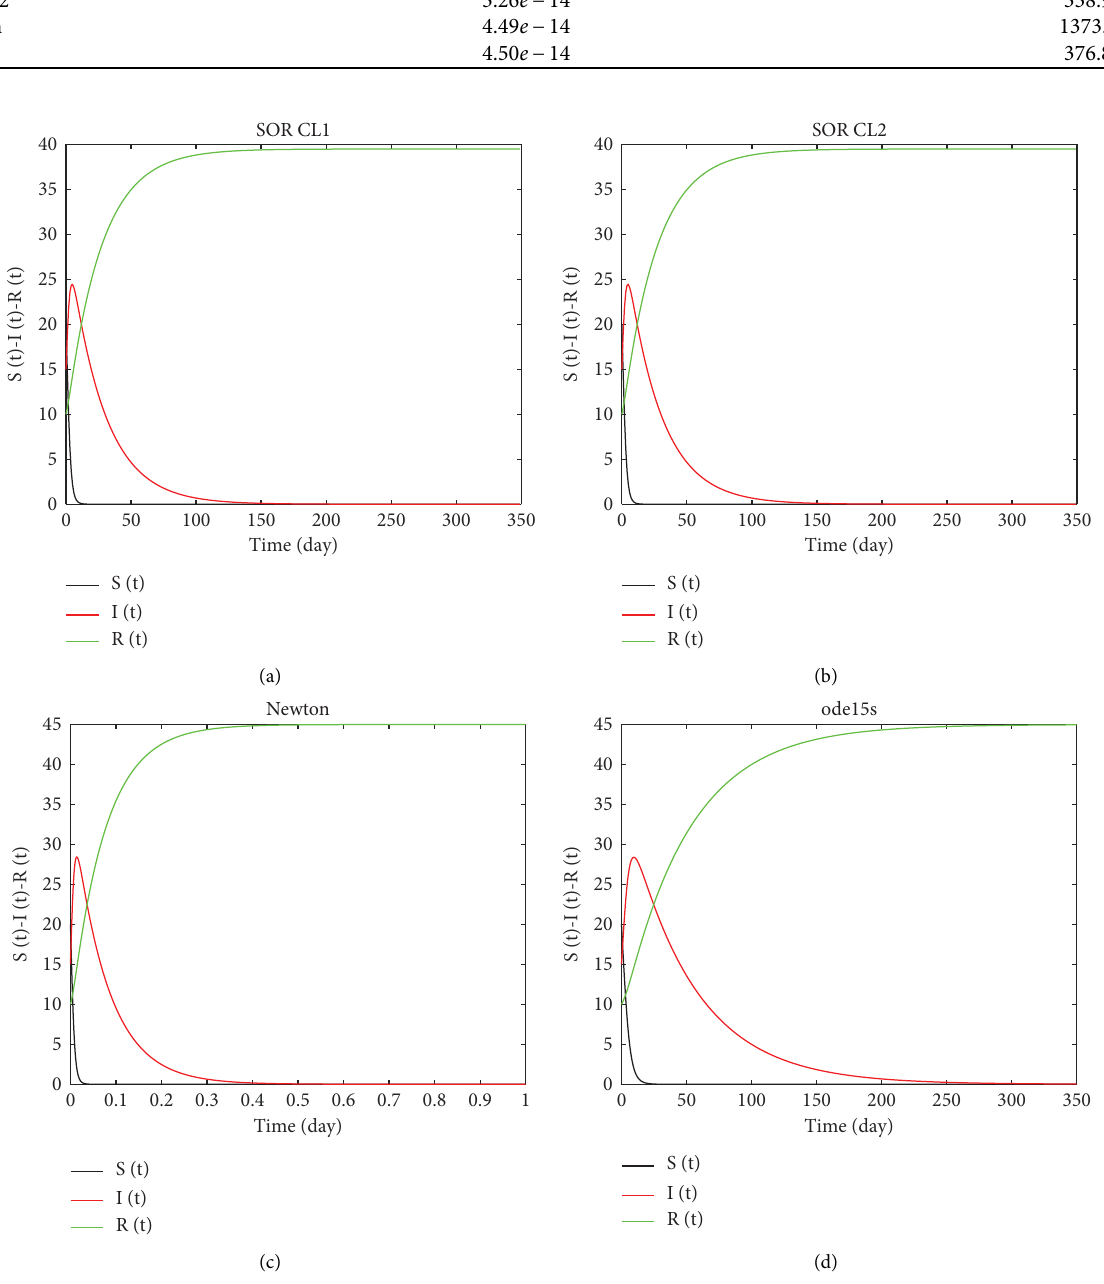
Figure 3: (a) Approximate values of S,I , and R using SORCL1 method. (b) Approximate values of S, I , and R using SORCL2 method. (c) Approximate values of S, I , and R using Newton’s method. (d) Approximate values of S, I , and R using ode 15 s